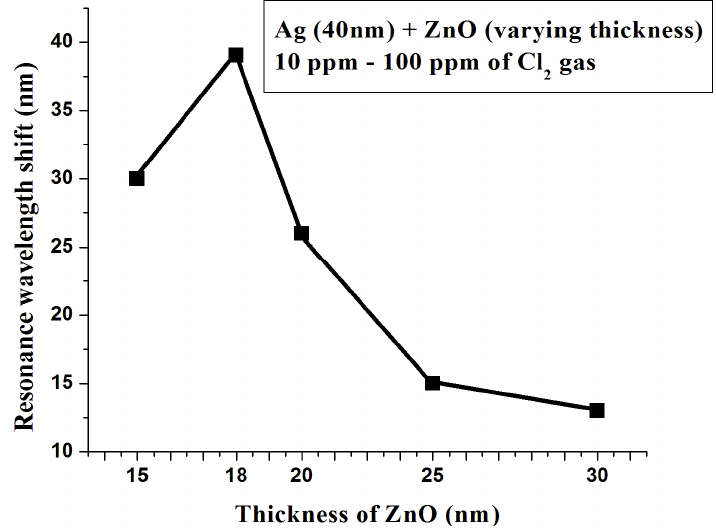
Figure 3. Shift in resonance wavelength as a function of thickness of zinc oxide thin film for the change in chlorine gas concentration from 10 ppm to 100